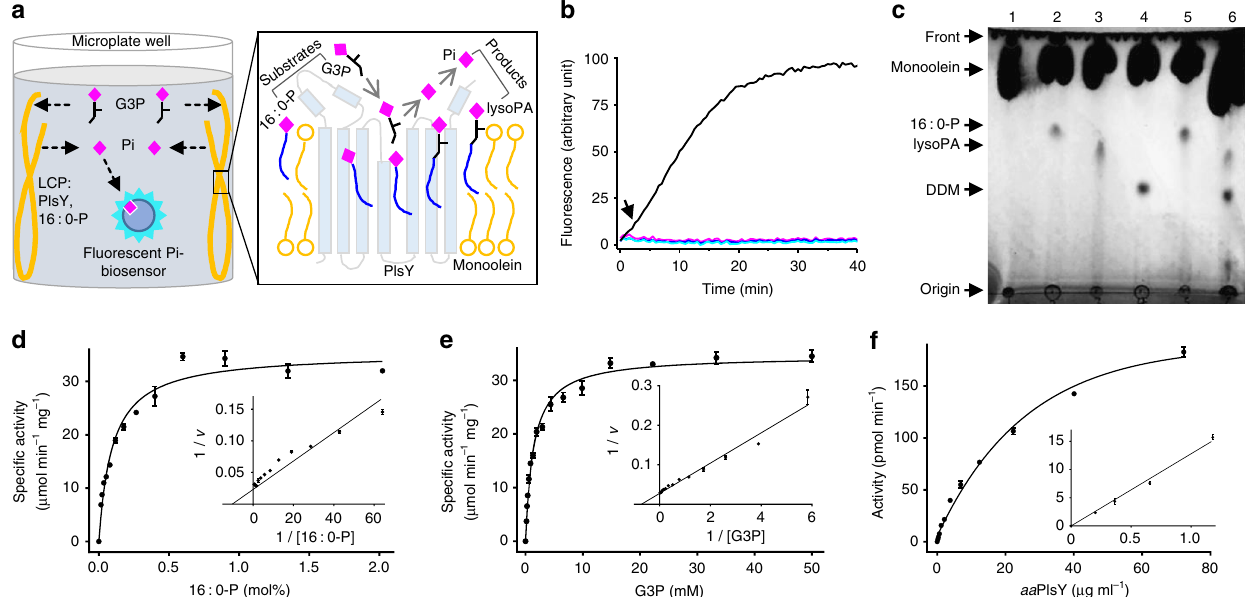
Fig. 1 Characterization of aa PlsY in LCP. a The principle of the Pi-biosensor assay. The sticky LCP loaded with aa PlsY and its substrate 16:0-P is dispensed at the side of a microplate well and is repeatedly soaked to remove contaminant Pi. G3P, pre-treated enzymatically with a Pi-scavenger 14 , diffuses from the bathing solution to LCP, and initiates the reaction. The product Pi is then released from LCP to the bathing solution, triggering fl uorescence increase of the Pi-biosensor 14 , which is monitored continuously using a plate reader. b Progress curves of the coupled assay omitting G3P (magenta), 16:0-P (cyan), enzyme (blue), and none of the above (black). The 2 min lag phase (indicated by an arrow) re fl ects the time required for equilibration of G3P between the bathing solution and LCP 16 ; the linear phase is used to calculate activity. c Thin layer chromatography assay of aa PlsY activity. Lane 1, monoolein; lane 2, monoolein with 16:0-P (substrate); lane 3, monoolein with lysoPA (product); lane 4, monoolein with n -dodecyl- β - D -maltoside; lane 5, reaction without aa PlsY; lane 6, reaction with aa PlsY. The brightness and contrast of the whole image have been adjusted to enhance the substrate and product bands. d , e Michaelis – Menten and Lineweaver – Burk plot (insets) of kinetic measurements for the indicated substrates. f Dependence of activity rate on enzyme loading. In d – f , data represent the average ± SD from triplicate